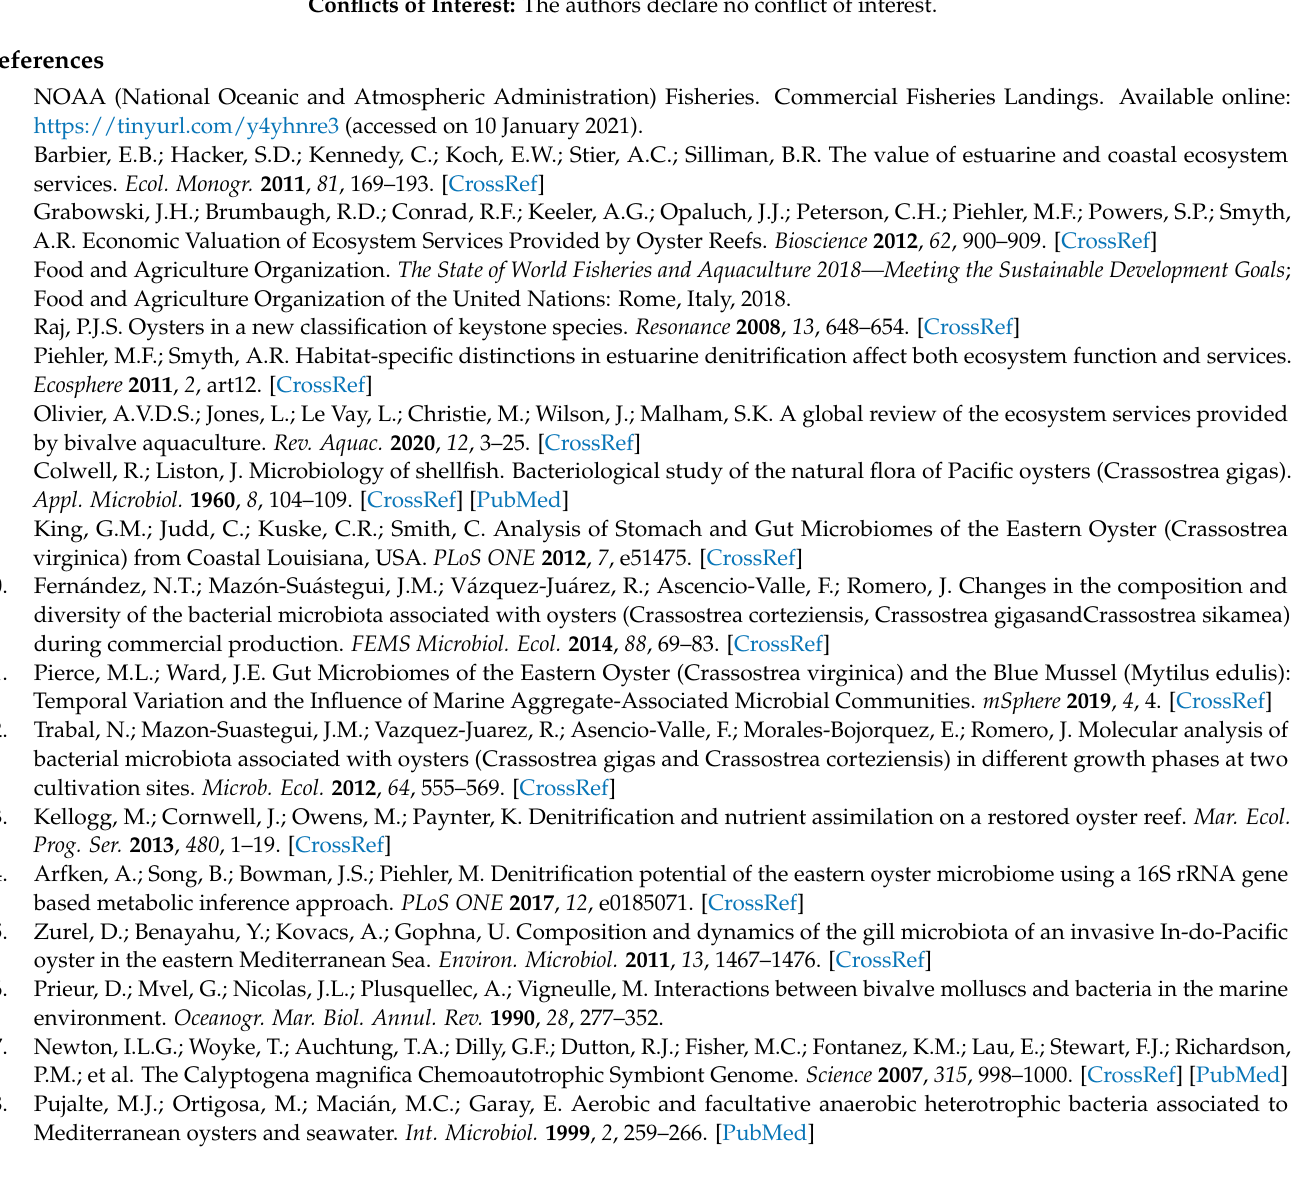
tives. Figure SI-3: Biosynthetic gene cluster analysis performed on isolated Pseudomonas species. Figure SI-4: Evaluation of the resistome or the suite of antimicrobial resistance genes within the genomes of the three isolated pseudomonads using the CARD